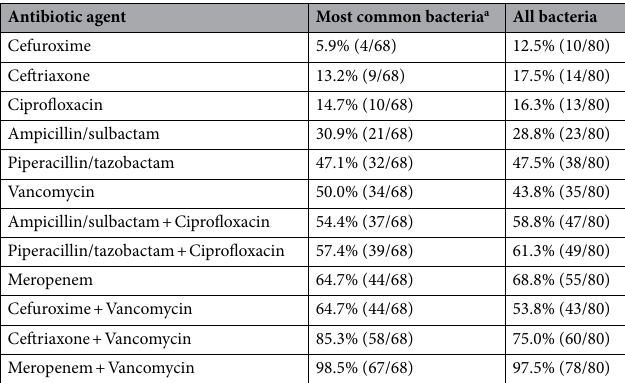
Table 5. Susceptibility of the bile duct colonizing isolates to antibiotic agents. a The most common bacteria which were found in the bile ducts were Enterococcus faecium , Enterococcus faecalis , Enterobacter chlocae , Escherichia coli , Klebsiella pneumoniae , Staphylococcus epidermidis , Klebsiella oxytoca , Hafnia alvei and Citrobacter